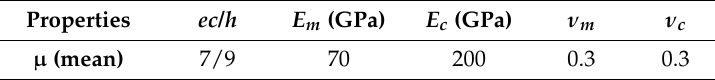
Table 5. Parameters mean values: case 3.2.1—Thicker